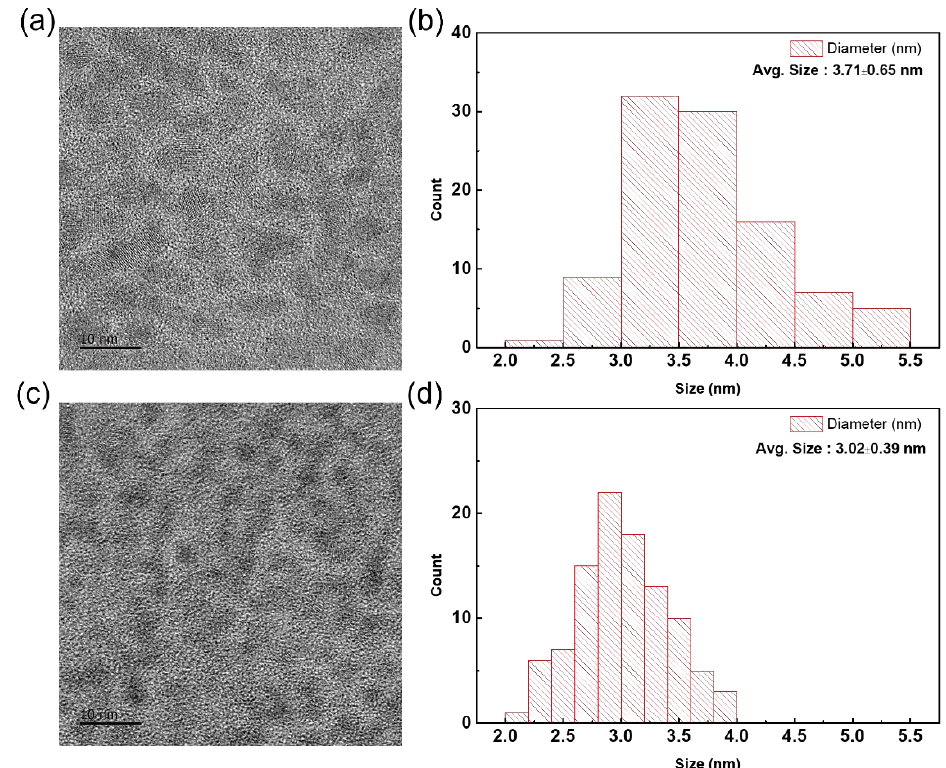
Figure 2. TEM images of synthesized In(Zn)P @ ZnS QDs and particle size distribution. ( a , b ) InP @ ZnS (Zn 0); ( c , d ) In(Zn)P @ ZnS (Zn 1.2).